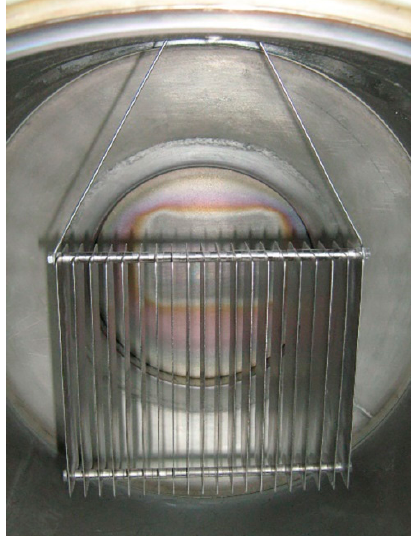
Figure 2. Inner view of the process chamber after etching a steel disc by 5-keV argon atoms produced by the grid composed of parallel plates.